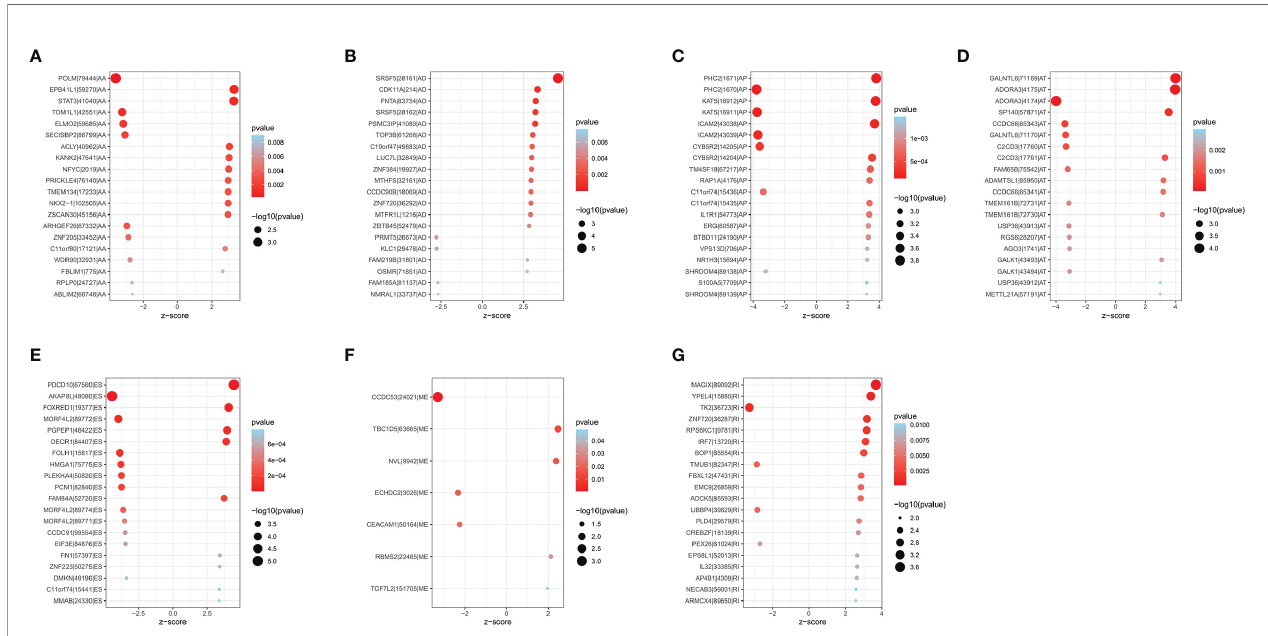
FIGURE 3 | Bubble plots of top 20 signi fi cantly OS-related AS events in THCA. Seven types of AS events were displayed from (A – G) .